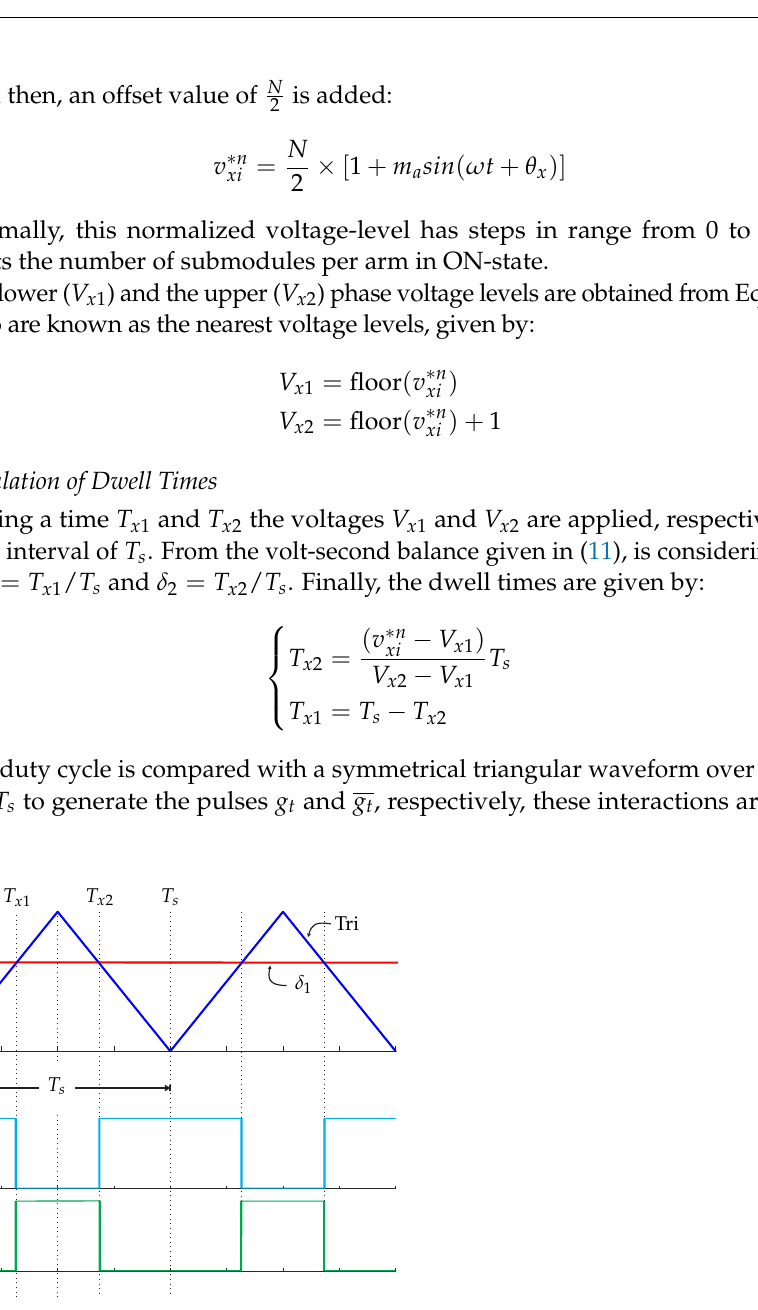
Figure 3. Dwell times of voltage levels, conventional SAM